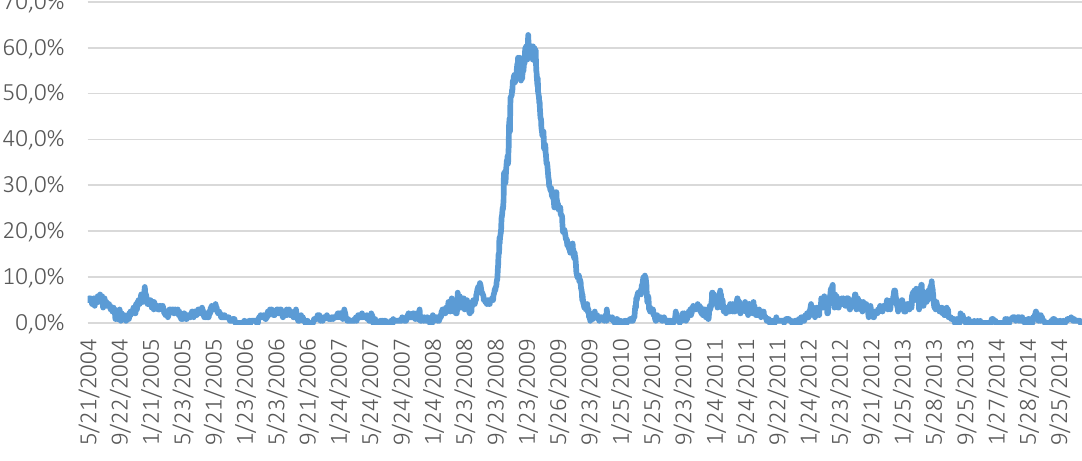
Figure 2. One-hundred (100) observations forecast